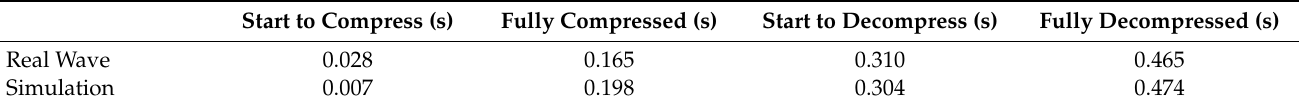
Table 1. Piston movement characteristics (real wave vs. simulation).